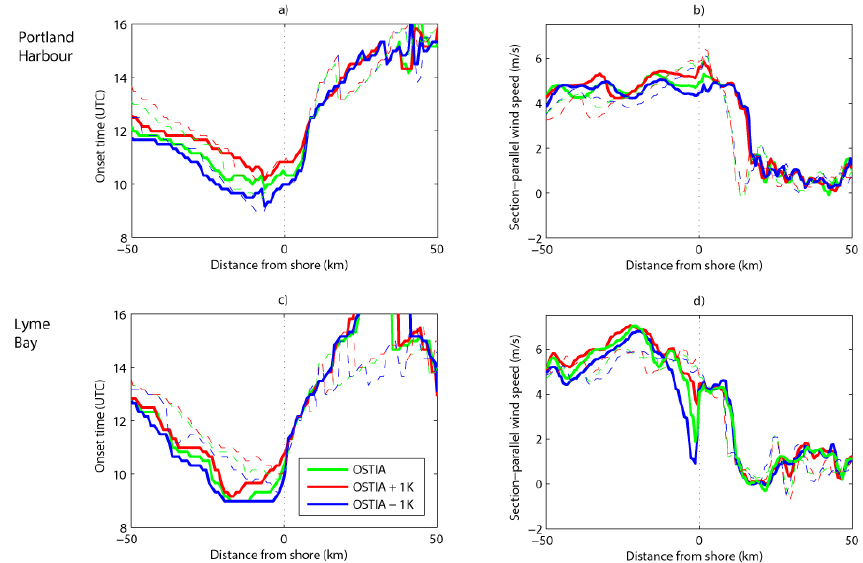
Fig. 7. Sea breeze onset time (left column) and 10m southwesterly wind component at 15:00UTC (right column) along SW–NE-oriented sections passing through Portland Harbour (first row) and Lyme Bay (second row). Experiments with orography are indicated by the solid lines, and experiments without orography are indicated by the dashed lines. The locations of Lyme Bay and Portland Harbour are shown in Fig. 1a, and the location of the cross sections are shown in Fig. 4b. Lines are plotted using model output with 10min temporal and 1km horizontal spacing. Positive distance is inland and negative distance is offshore.